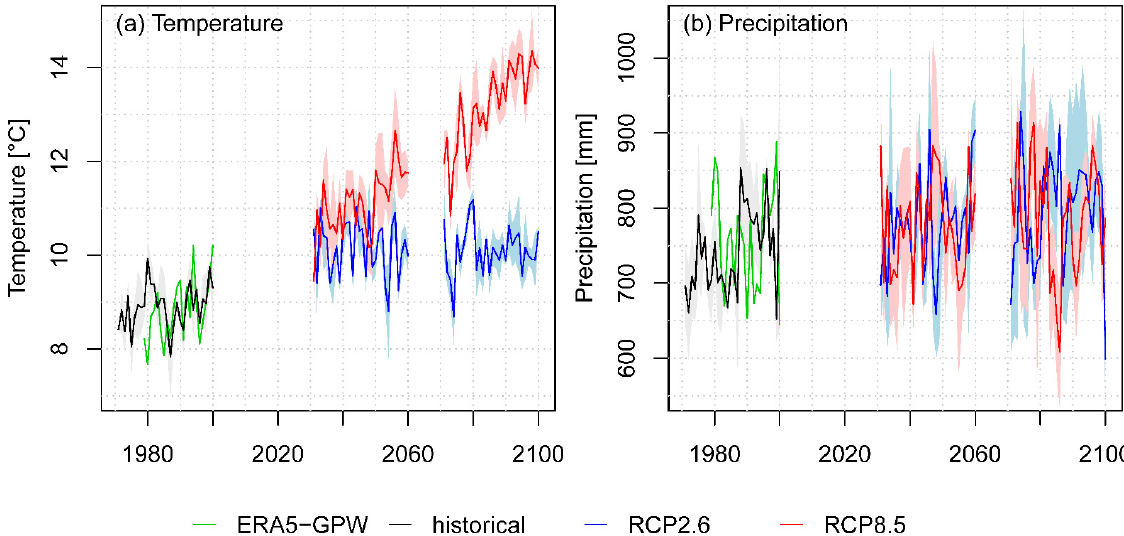
Figure 3. Mean annual temperature [°C] ( a ) and precipitation [mm] ( b ) according to the historical ERA5-GPW-driven simulation (1980–2000) [23] (green) and to the historical GCM-RCM-driven simulations (ensemble mean; 1971–2000) (black) as well as according to the GCM-RCM-driven simulations (ensemble mean) under RCP2.6 (blue) and RCP8.5 (red) for the near future (2031–2060) and the far future (2071–2100) on spatial average over the whole Danube River Basin. Lines: ensemble mean; shadings: standard deviation of the ensemble.